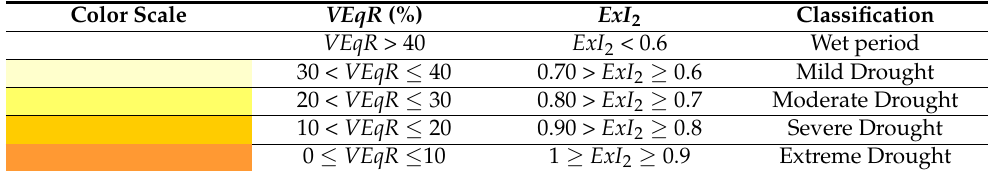
Table 3. Drought classifications based on VEqR and ExI 2 ranges.